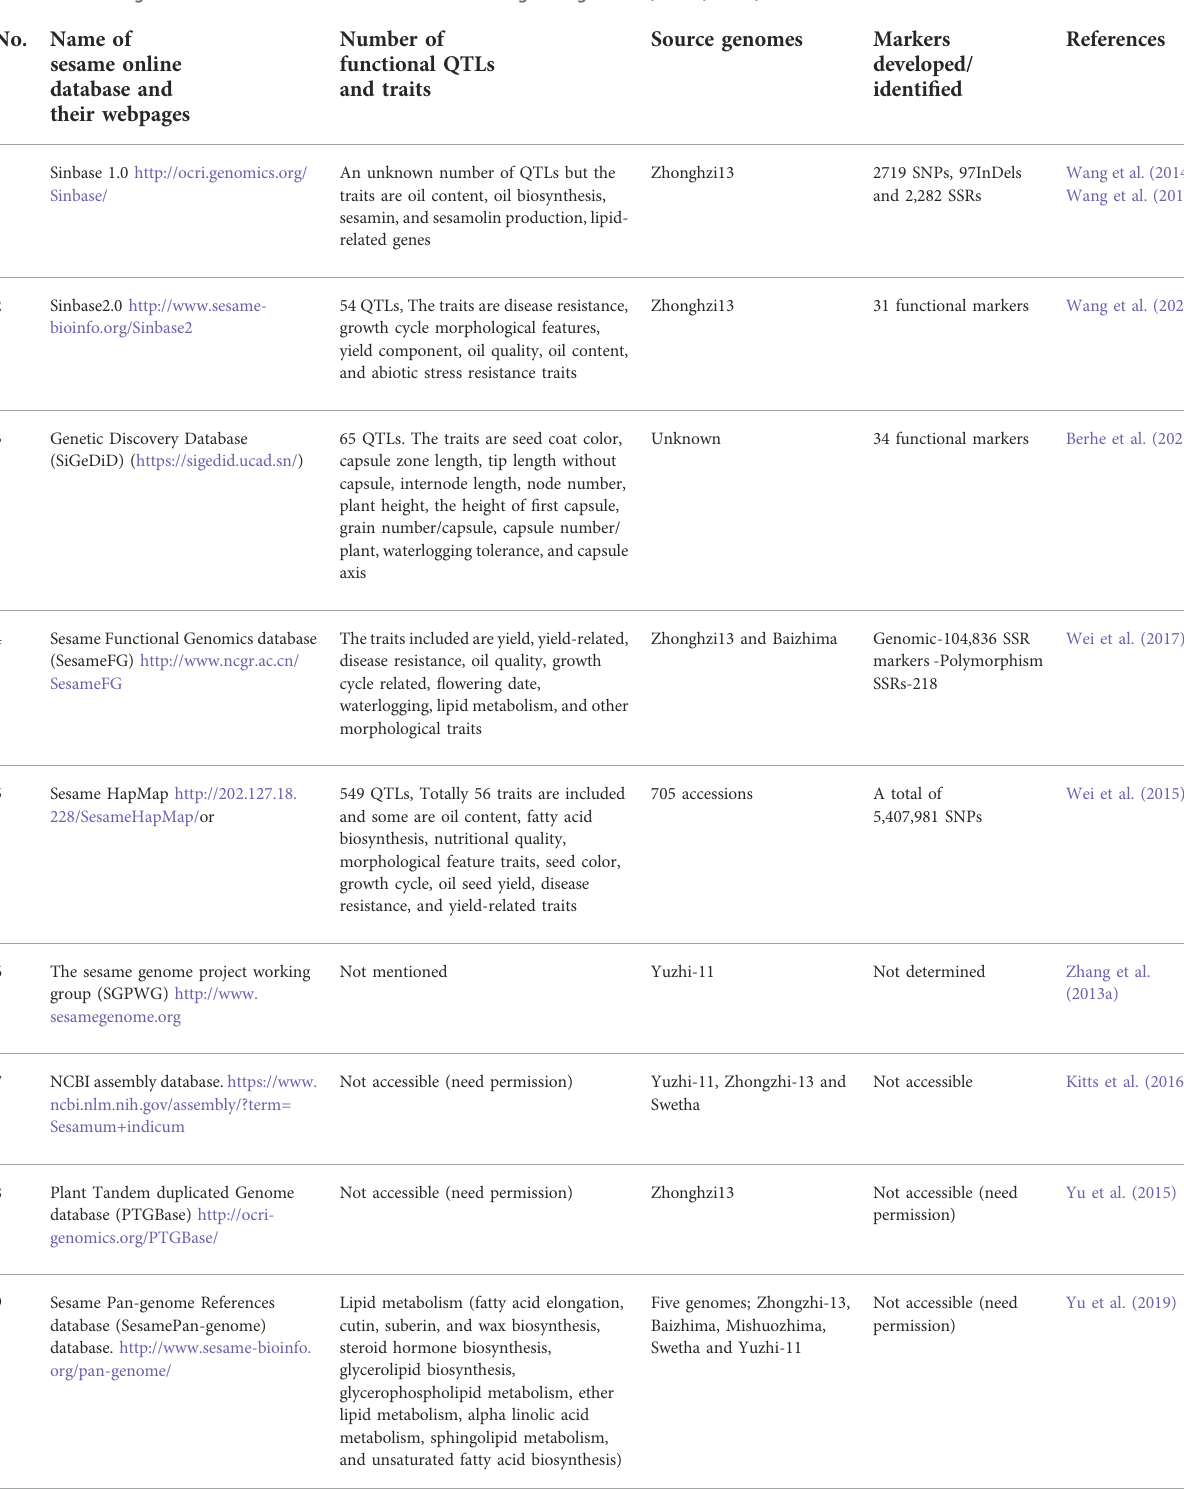
TABLE 1 Sesame genome online databases and numbers of integrated genomes, traits, QTLs, and